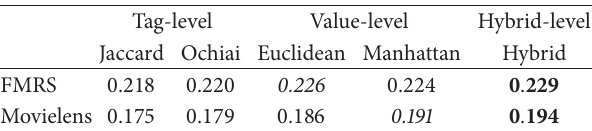
Table 4: The performance with different metrics in Collaborative on two data